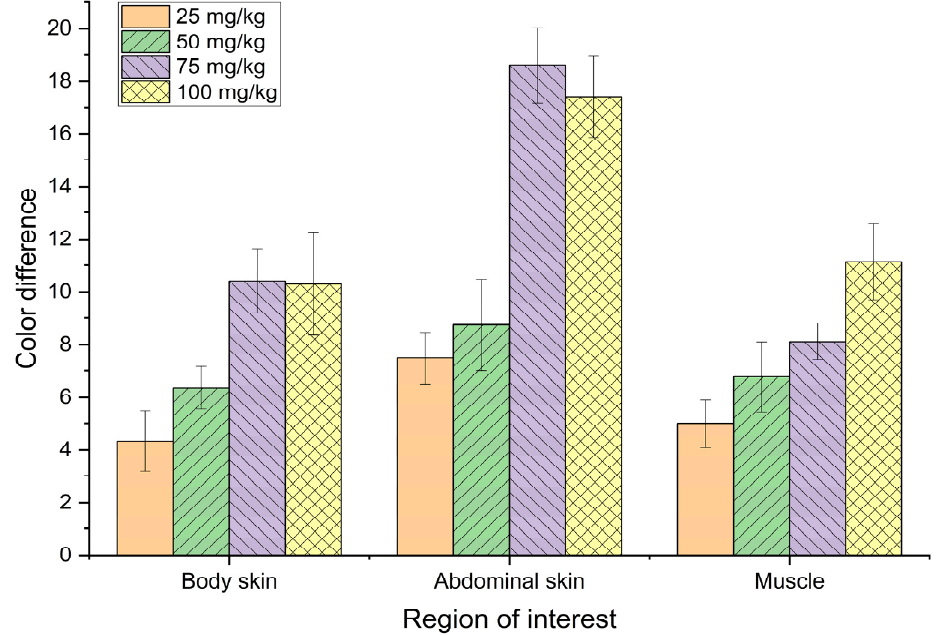
Figure 7. Various colour performance of bighead catfish fed various xanthophyll diets for 4 weeks. Sensory evaluation and accumulated carotenoids in the muscle tissue of fish fed